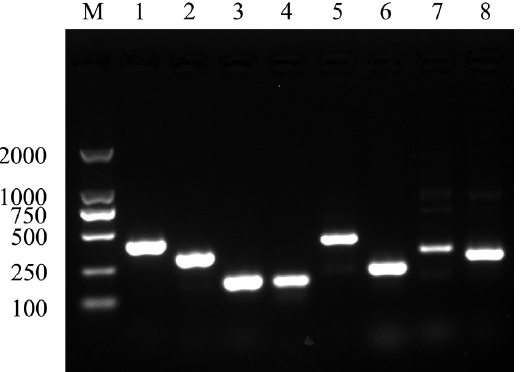
Figure 5. The extracellular enzyme test results of strain GJL1.